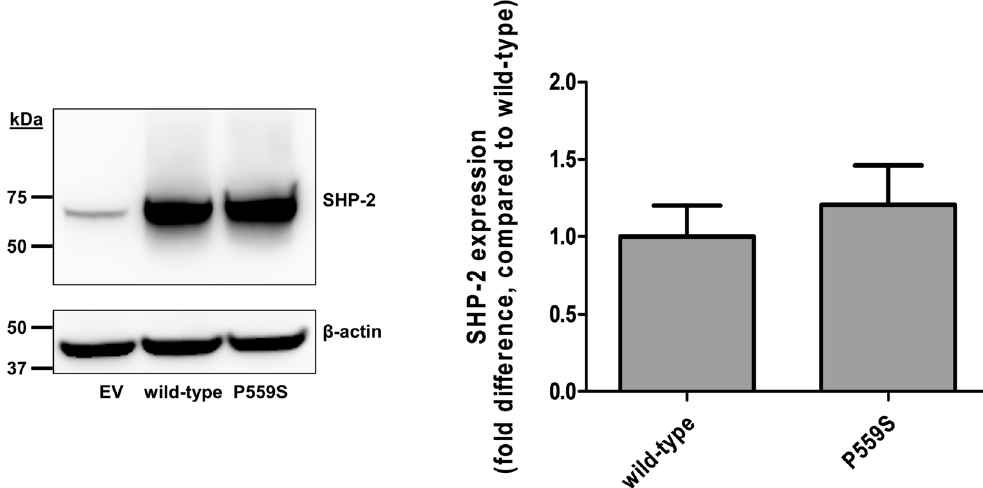
Figure 3. Effect of a variation, P566S, on SHP-2 expression. SHP-2 expression was investigated using immunoblotting after transfection of wild-type SHP-2 or P566S variation vectors into HCT-116 cells. Data shown represent mean ± SD obtained from three independent experiments and analyzed by Student’s two-tailed t -test. EV; empty